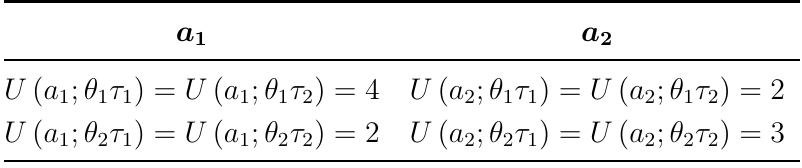
Table 1. First period